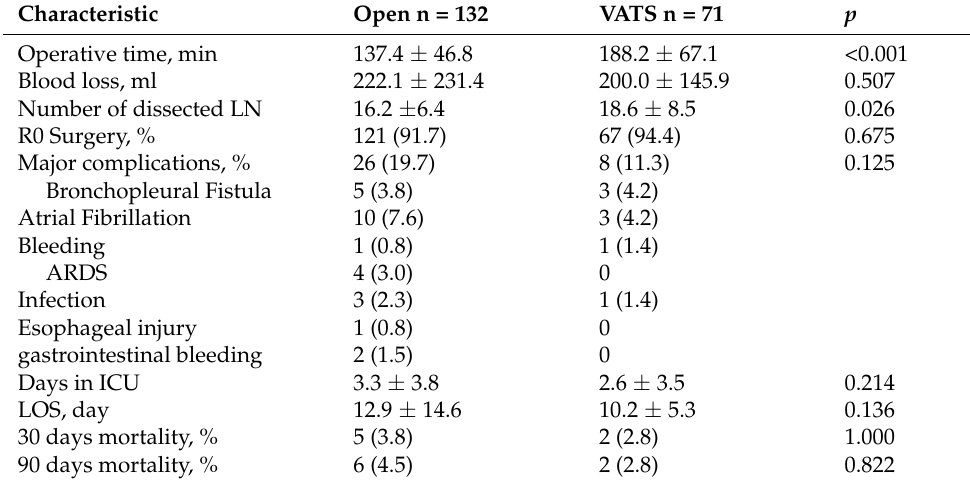
Table 2. Perioperative outcomes between Open and VATS pneumonectomy patients after propen- sity-score matching.